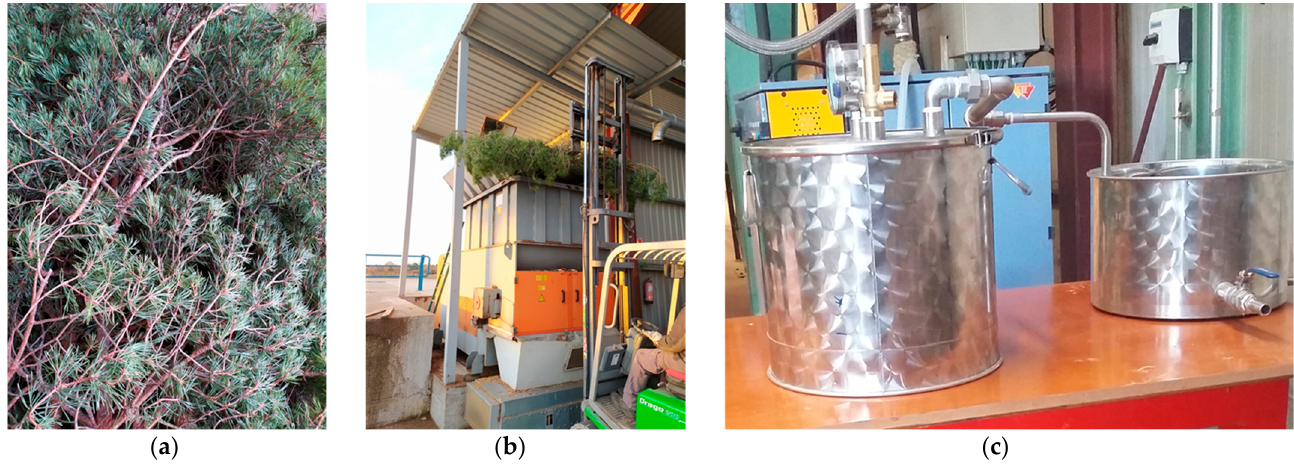
Figure 3. Processes carried out during the pretreatment of Pinus sylvestris to obtain essential oil: ( a ) vegetal material collected manually, ( b ) milling, and ( c ) distillation of the milled biomass.